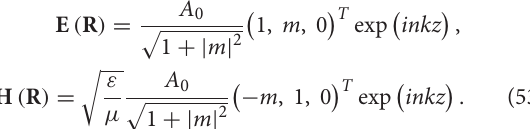
0, τ 1, Equations (55), = = caused by the OM (66), ||